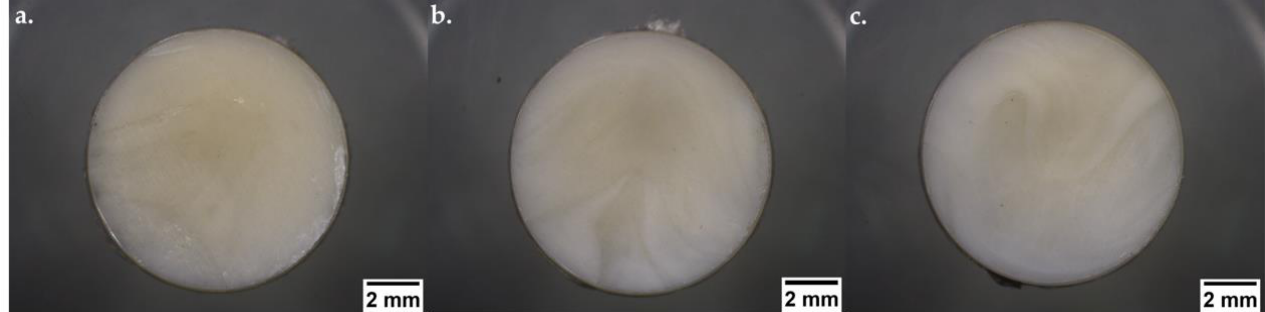
Figure 3. Digital photographs (ShuttlePix Digital Microscope, Nikon Corporation, Tokyo, Japan) displaying the physical aspects of µIM tablets: ( a ) SDF 1, ( b ) SDF 2, and ( c ) SDF 3.